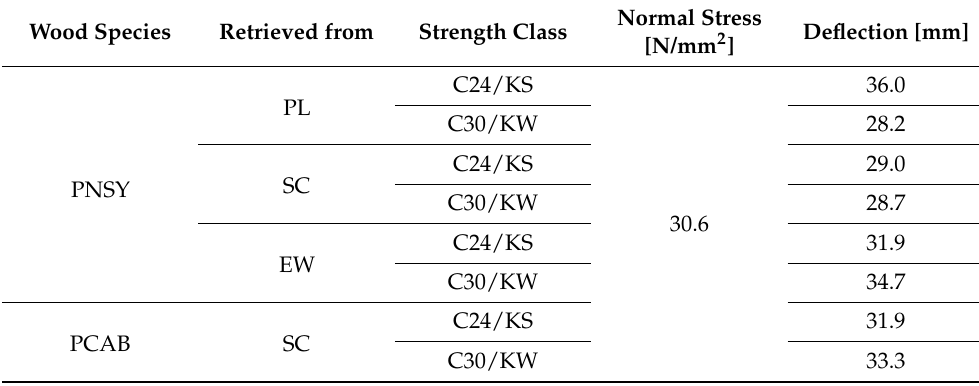
Table 5. Normal stresses and deflection (displacement) of the A version long frames made of solid wood material.